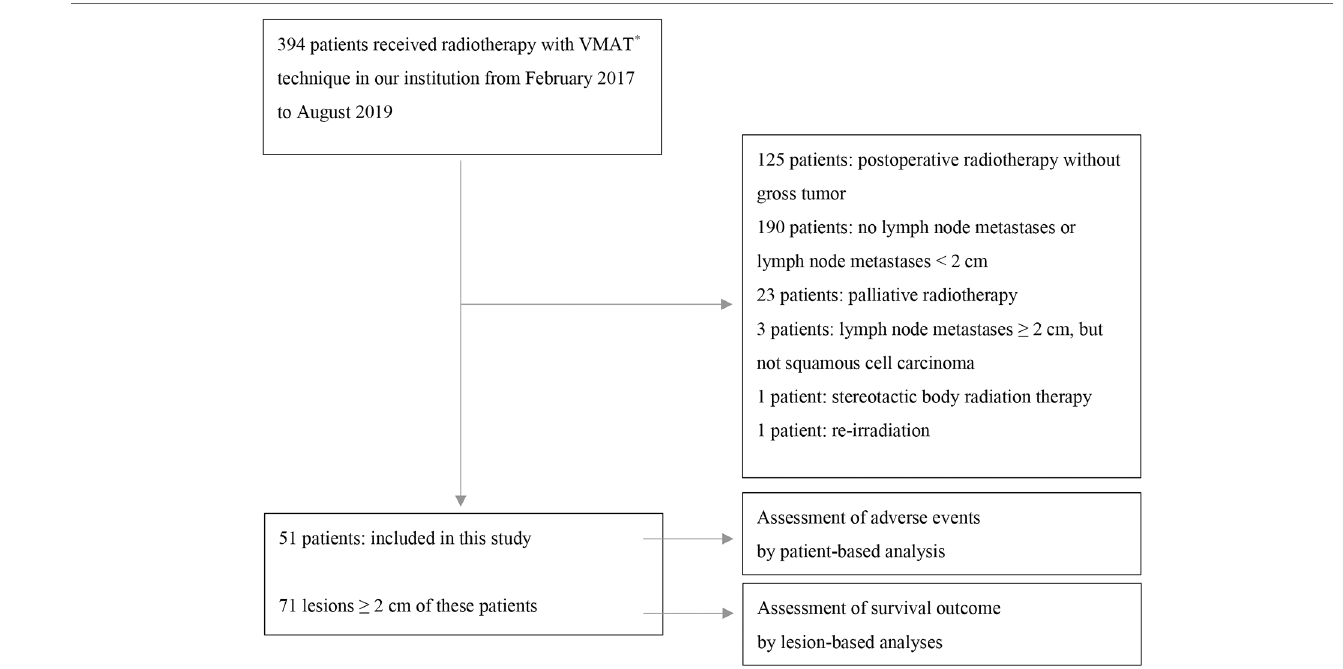
TABLE 1 | Flowchart of patient inclusion.